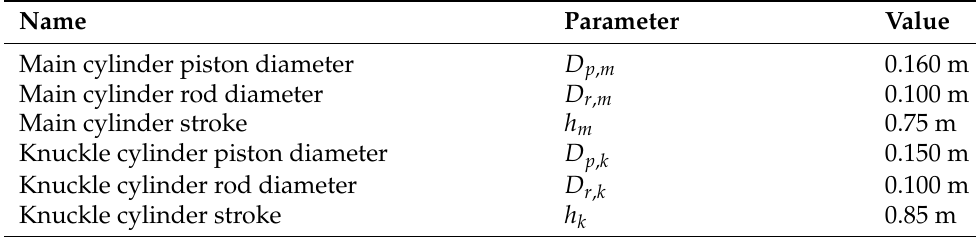
Table 2. Cylinder